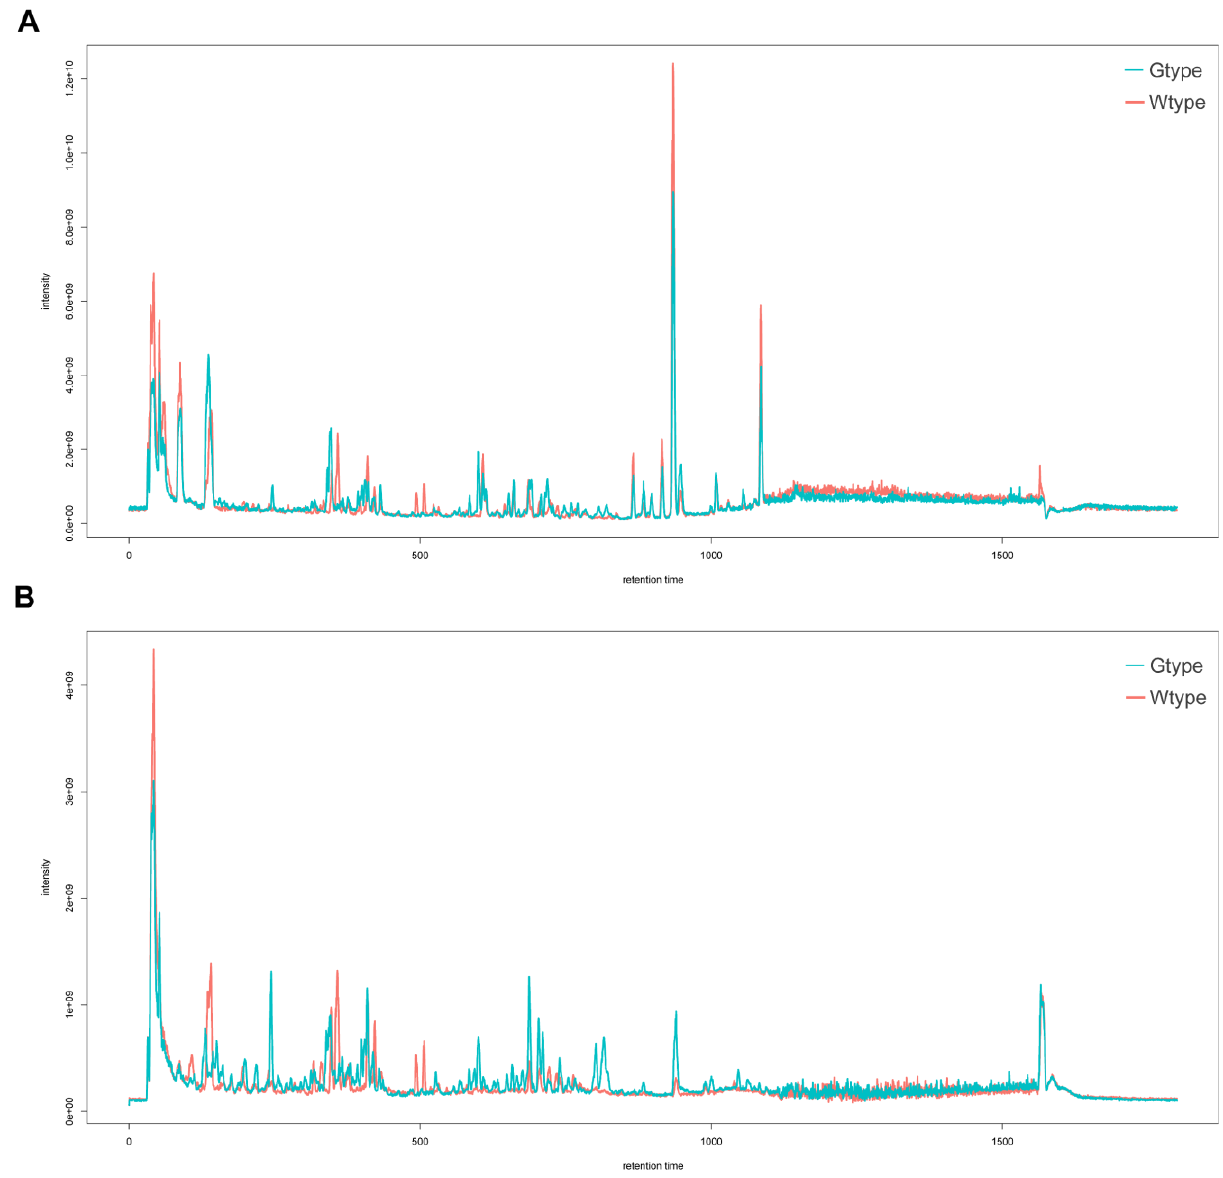
Figure 1. The representative total ion chromatograms of the two types of P. sibiricum acquired in positive ( A ) and negative ( B ) ionization modes.